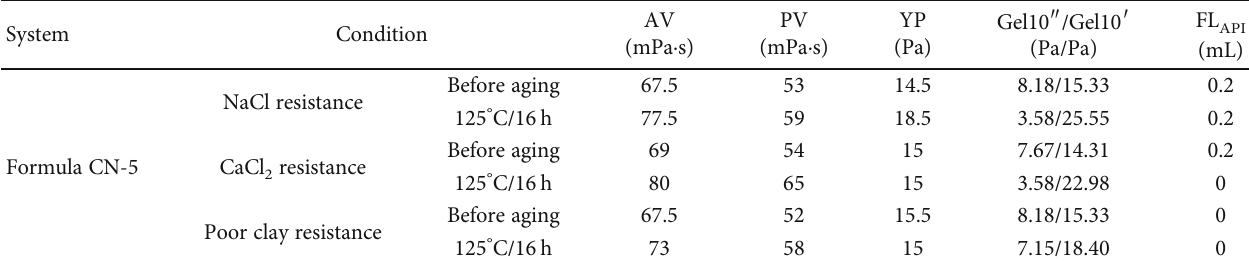
Table 8: Pollution resistance evaluation results of strong plugging drilling fl uid.